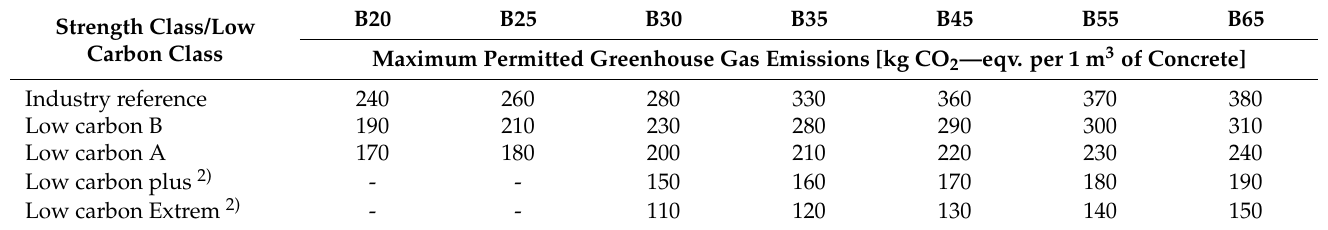
Table 5. NB’s No. 37 overview of greenhouse gas emissions to the low-carbon classes compiled with the industry reference